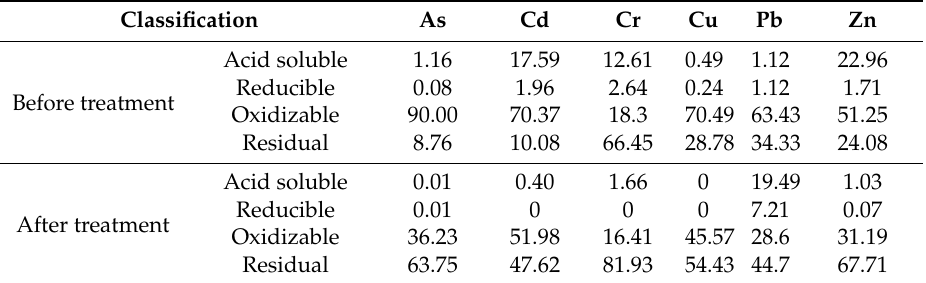
Table 7. Chemical speciation of arsenic and heavy metals by BCR procedure (wt.%) in the raw and treated